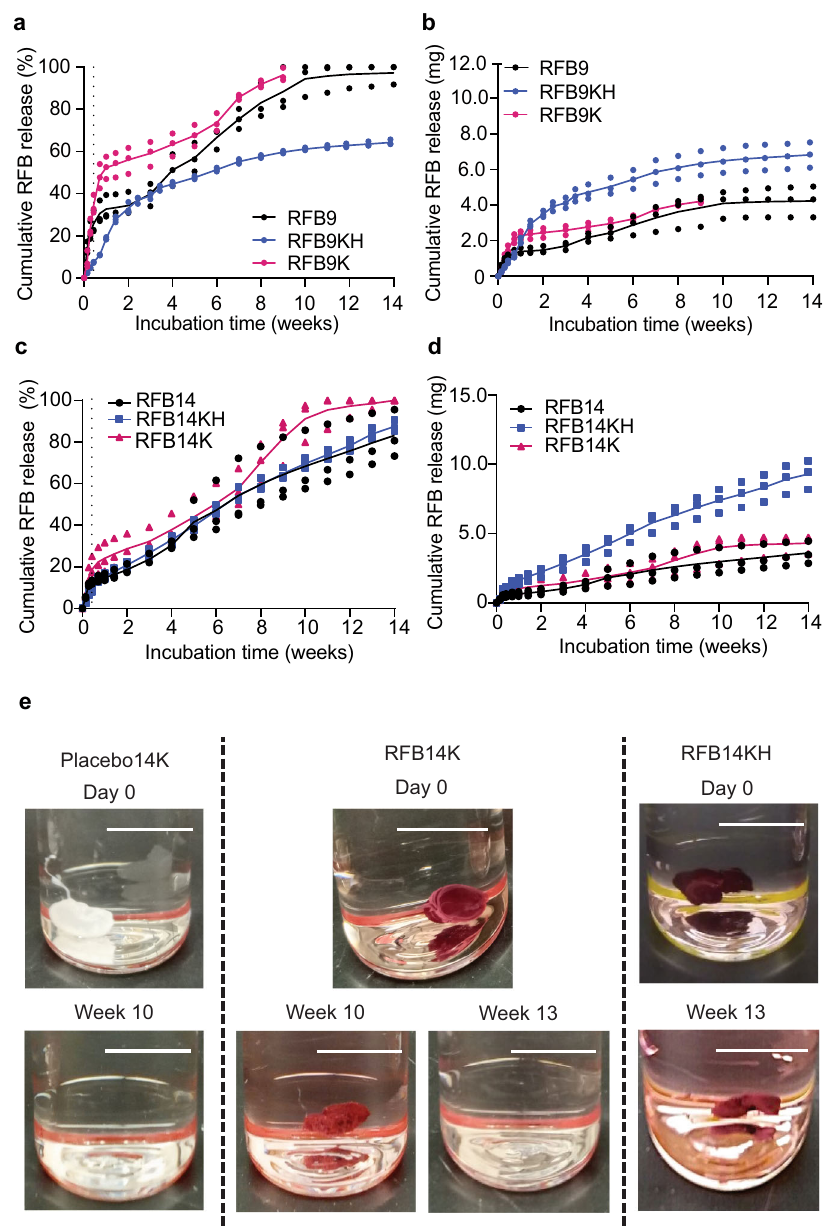
Fig. 4 | Impact of Kolliphor ® HS 15 and increased drug load on RFB release kinetics from ISFI formulations. a – d In vitro evaluation of formulations RFB9 (127mgg − 1 RFB) and RFB14(130mgg − 1 RFB) with formulations withhigh drug load and 0.45wt% Kolliphor ® HS15(RFB9KH: 293mgg − 1 RFB, RFB14KH:294mgg − 1 RFB), and formulations containing Kolliphor ® HS 15 and the same drug load as RFB9 and RFB14 (RFB9K: 128mgg − 1 RFB, RFB14K: 132mgg − 1 RFB) ( n =3 per formulation). Cumulative RFB release in % over time of RFB9, RFB9KH, RFB9K ( a ) and RFB14,